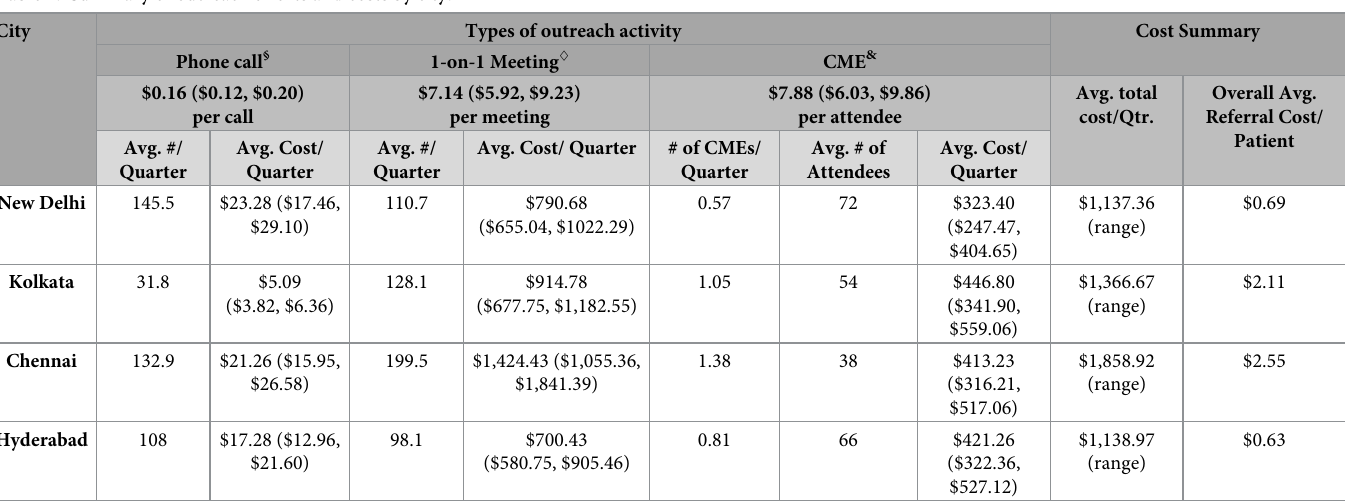
Table 2. Summary of outreach efforts and costs by city.